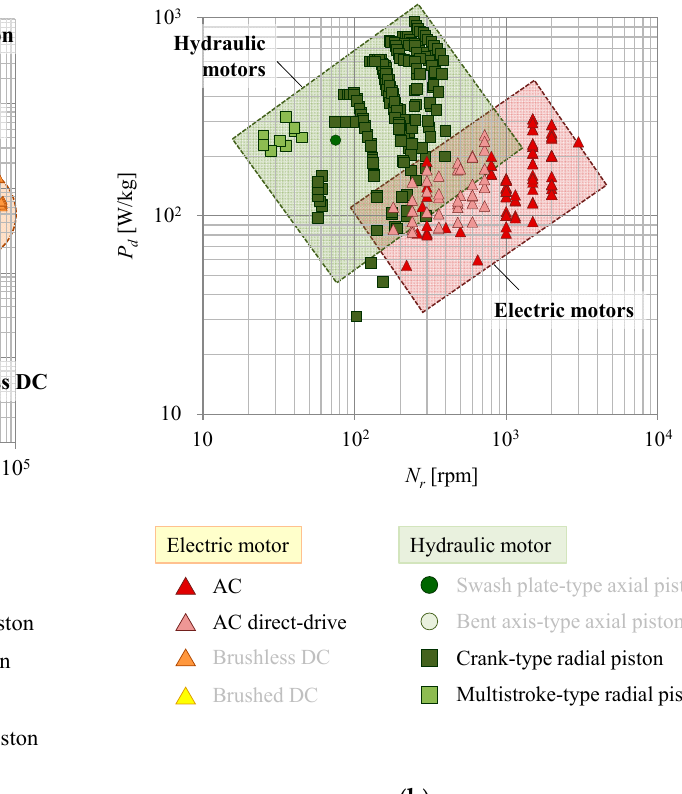
Figure 11. Correlation between motor weight and power density.